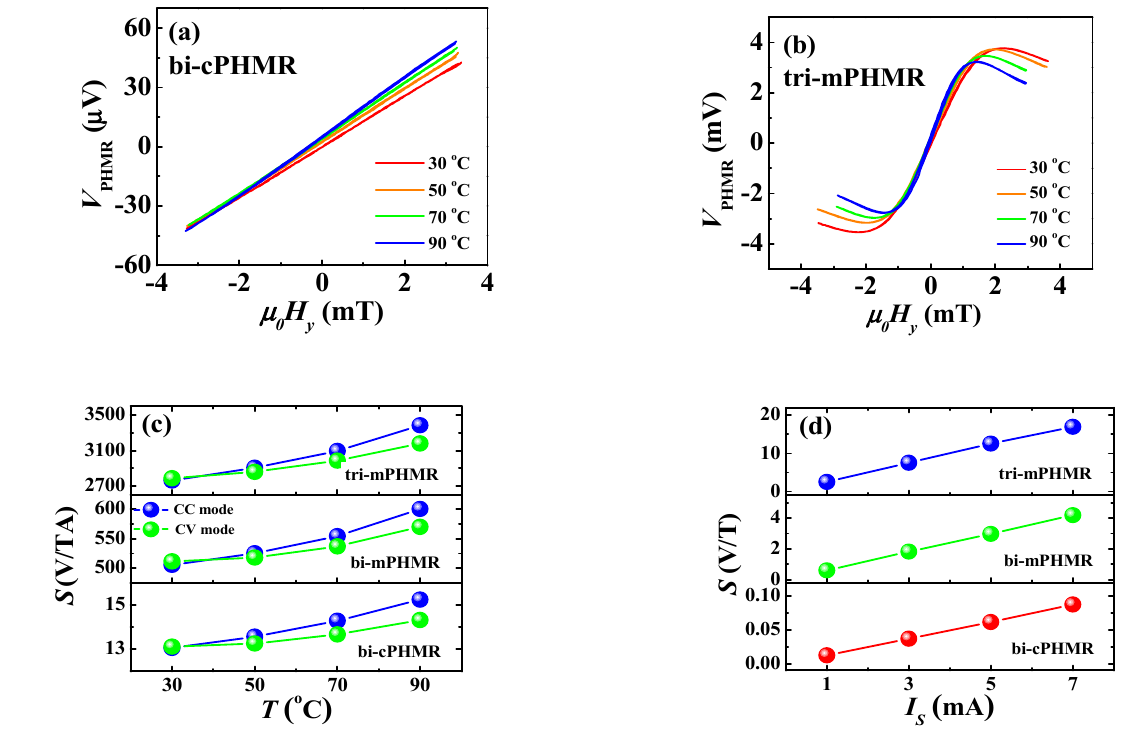
Figure 3. ( a , b ) Change in PHMR voltage with temperatures in CC mode for bi-cPHMR and tri-mPHMR sensors; ( c ) sensitivity change with temperature and applied sensing current for 1 mA; ( d ) sensing current dependence on sensitivity.